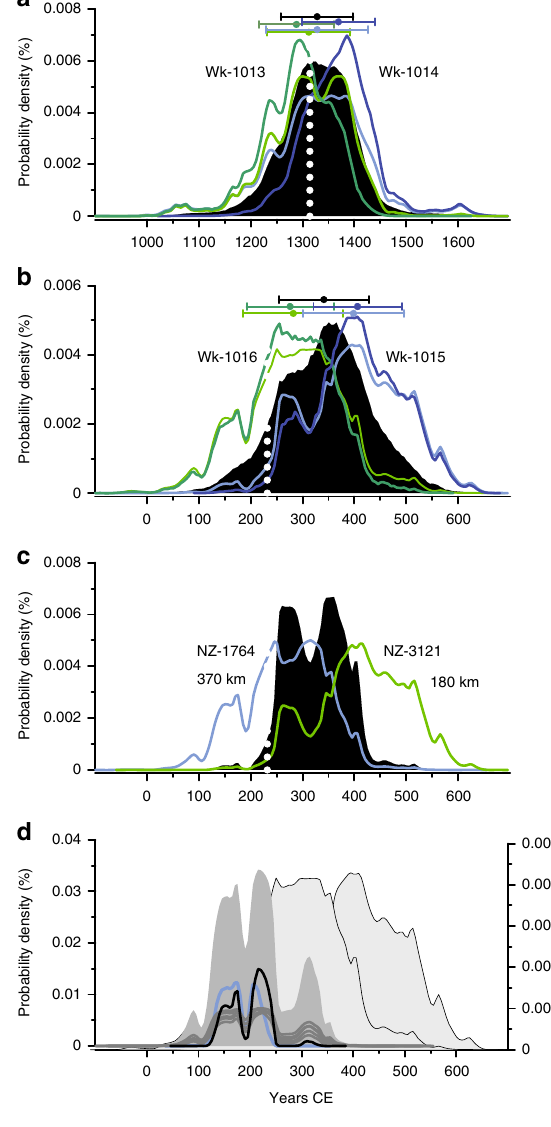
Fig. 3 Distant sites yield younger eruption dates. Calibrated 14 C age distributions for samples bracketing the Kaharoa (Mt Tarawera) and Taupo tephras at sites remoted from the volcanoes and for seeds and leaves from the buried forests at Benneydale and Pureora (near the wiggle match tree). a Unmodelled (light green and blue) and modelled (dark green and blue) offsets attributed to Rafter laboratory ages) on peat samples bracketing the